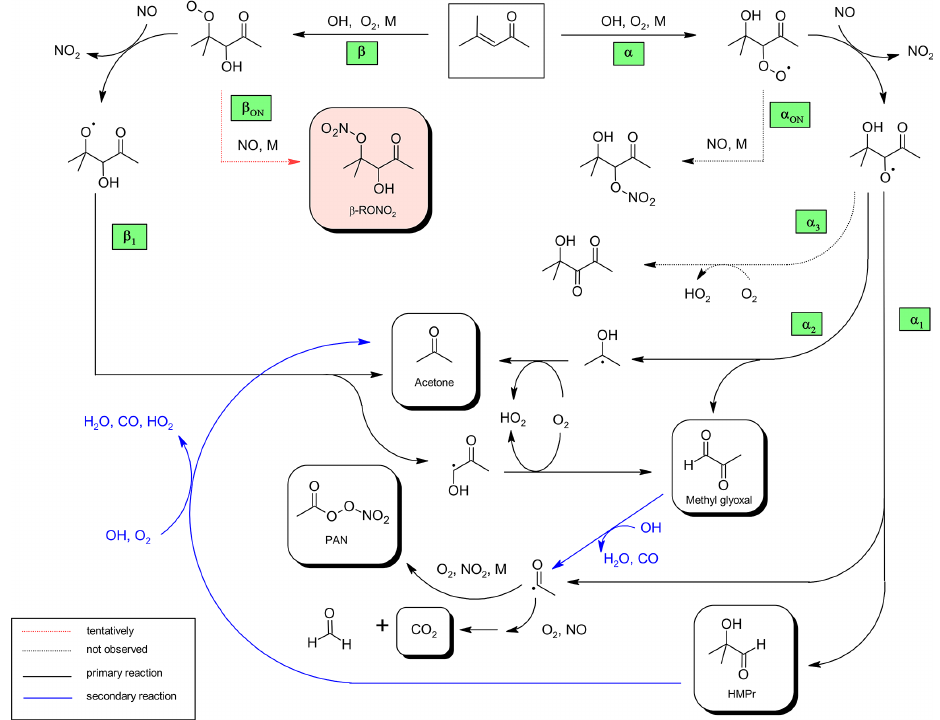
Figure 6. Proposed mechanism for the OH-radical-initiated oxidation of 4-methyl-3-penten-2-one and further oxidation of the first-generation products relevant under the experimental